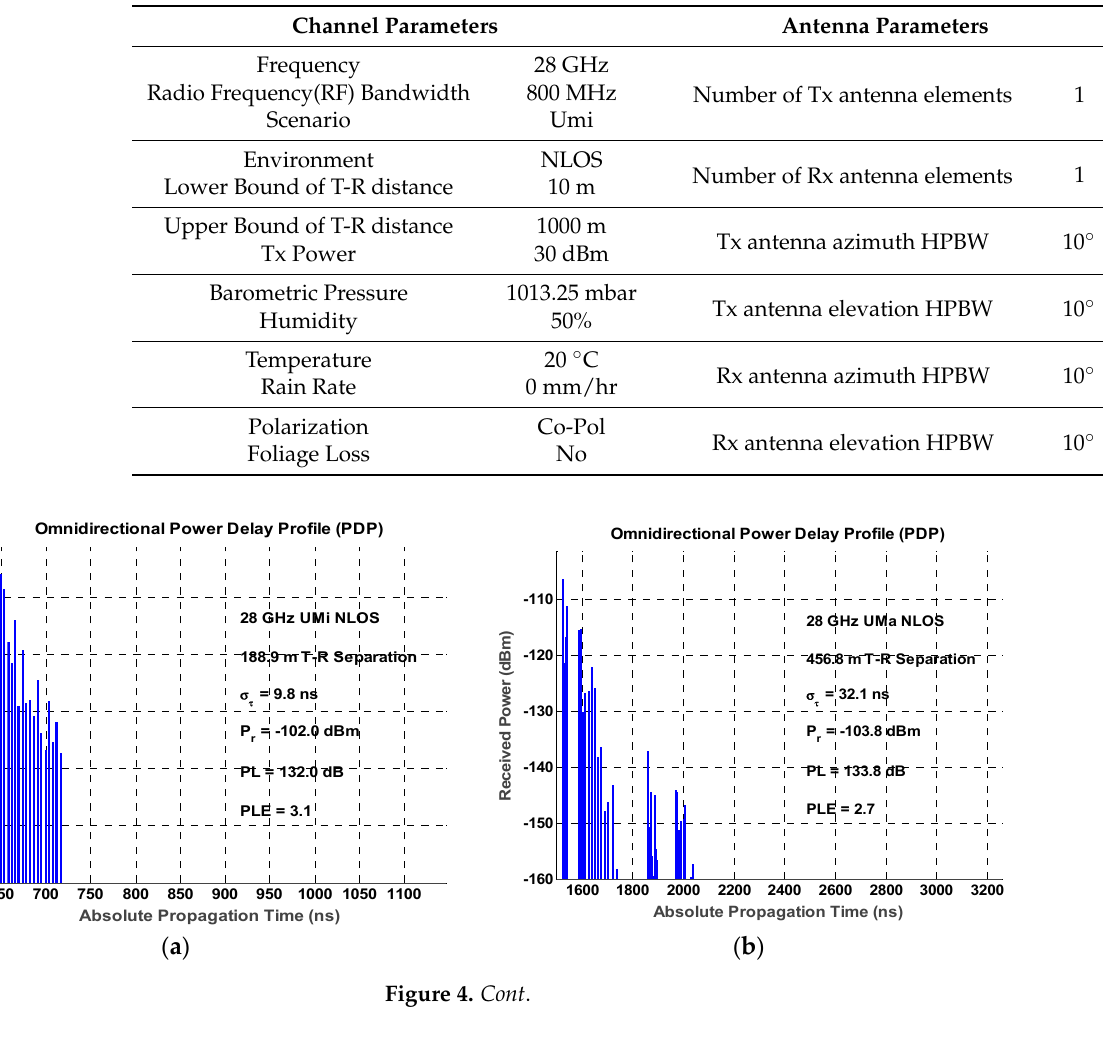
Table 2. Input Parameters NYUSIM Simulator.